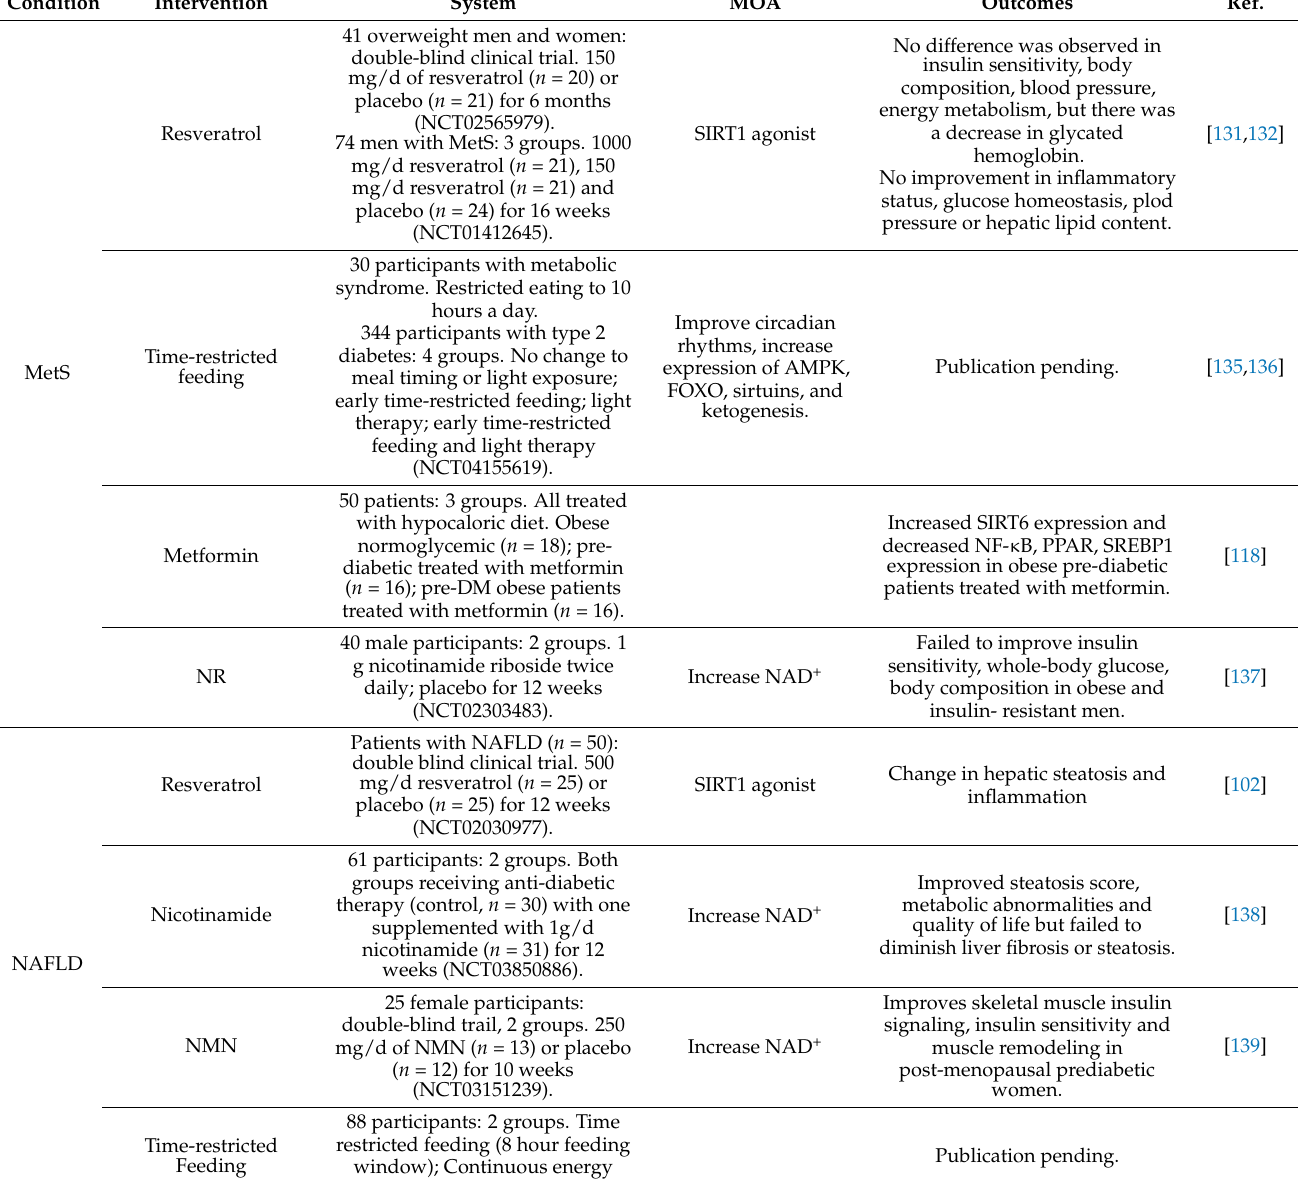
Table 1. Pharmacological intervention of mitochondrial acyl post-translational modifications related to hepatic disease progression in patients. Abbreviations: AMPK, Adenosine monophosphate- activated protein kinase; d, day; DM, diabetes mellitus; FOXO, forkhead box1; MetS, metabolic syndrome; NAD + , nicotinamide adenine dinucleotide; NAFLD, non-alcoholic fatty liver